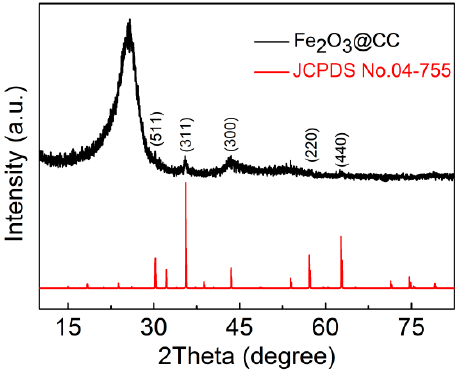
Figure 1. XRD pattern of the Fe 2 O 3 @CC composite.